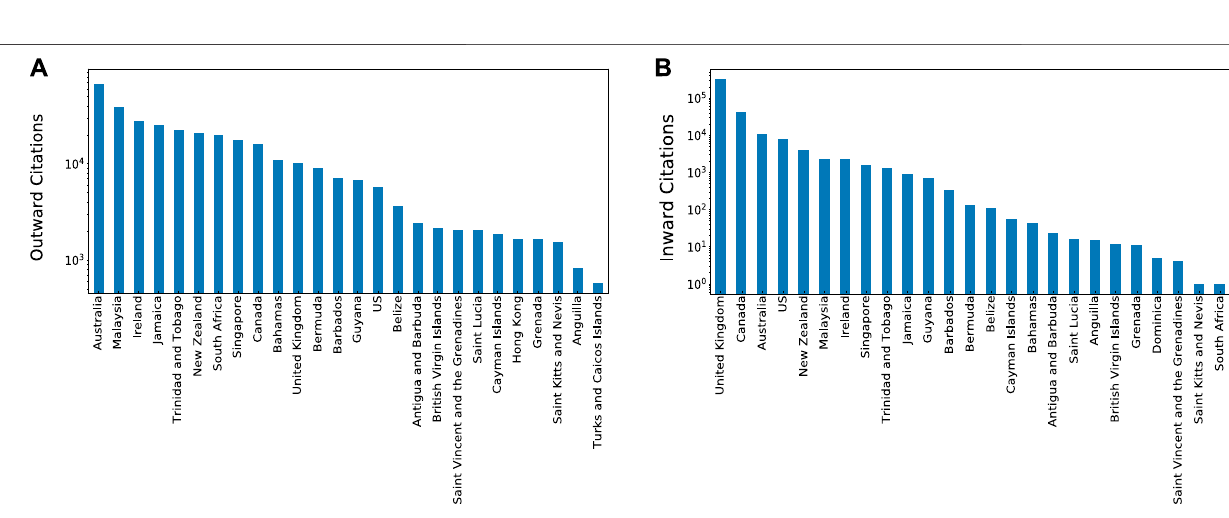
FIGURE8| Citationdistributionsinthecross-jurisdictionalnetwork. (A) Outwardcitationsforeachcountry (B) Inwardcitationspercountry.Australiaisshowntobe themostproli fi cuserofforeigncaselawbyoutwardcitations.JudgmentsofcourtsintheUnitedKingdom,chie fl ycourtsofEnglandandWales,arethemostcitedsource of case